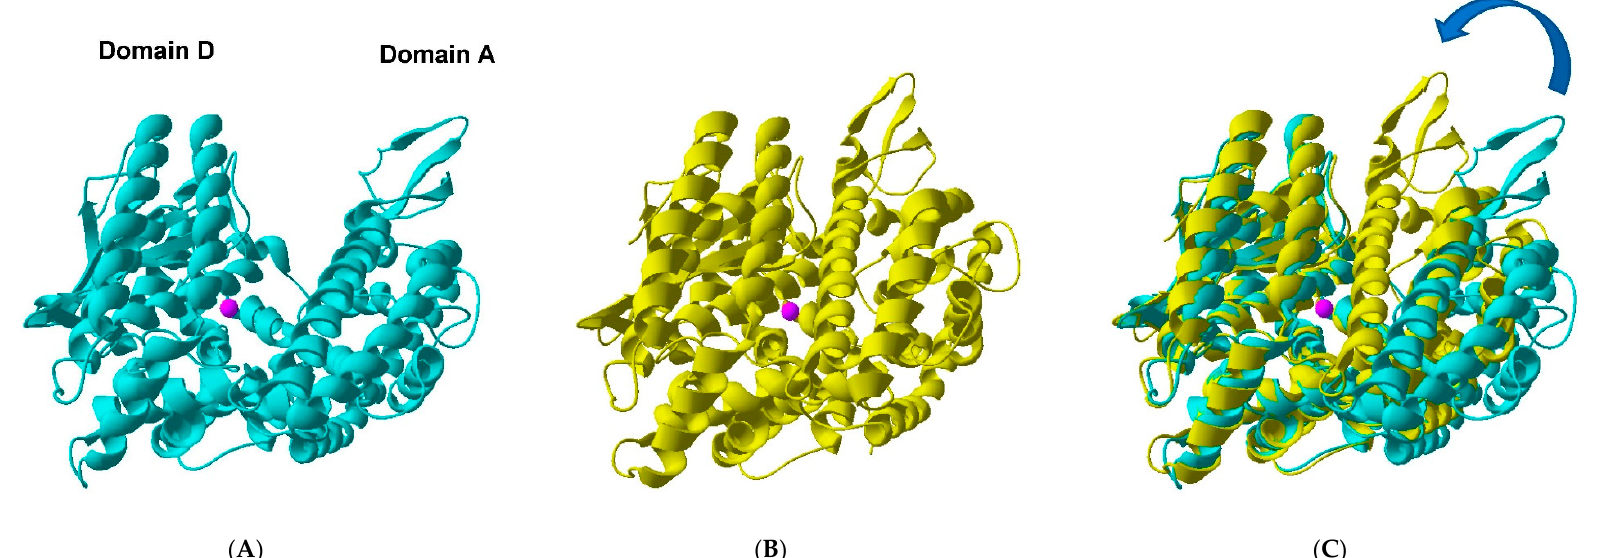
Figure 1. Open versus closed TOP. ( A ) Ribbon representation of the “open” TOP crystal structure (PDB 1S4B). ( B ) Ribbon representation of the modelled “closed” TOP structure. The model was based on the recently published structure of human neurolysin E475Q mutant in complex with neurotensin peptide products (PDB 5LUZ). ( C ) Overlay of the two TOP molecules fixing the zinc binding site HExxH + E + Zn 2+ (pink sphere). The arrow highlights the relative change in position of domains D(onor) and A(cceptor) that should occur considering the hinge-like closing of TOP (see also Figure 2).